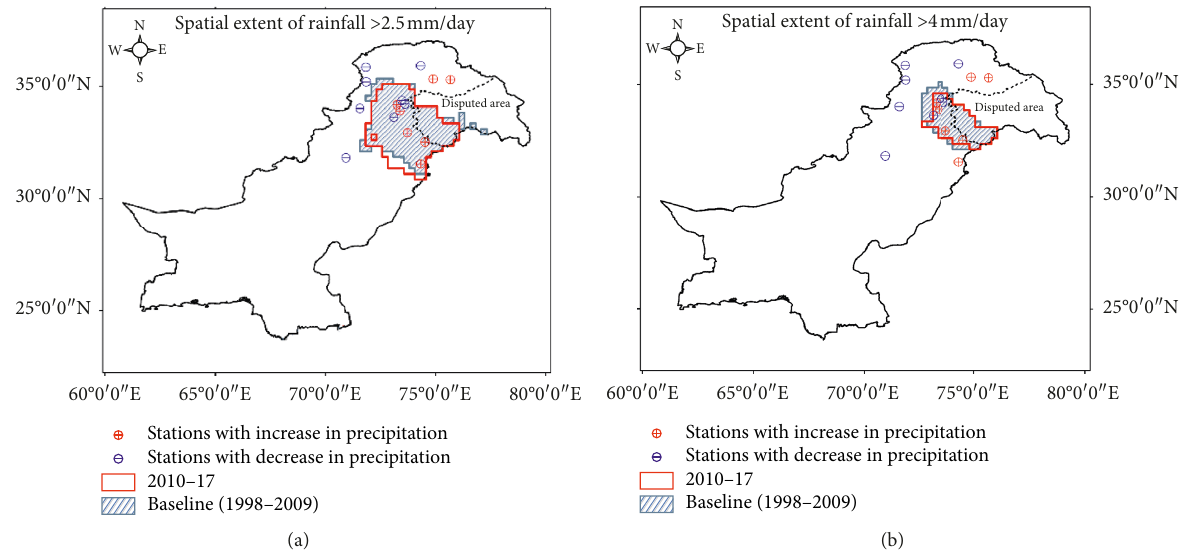
Figure 11: Spatial Shift of monsoon in northern monsoon belt of Pakistan. There is an increase in monsoon hit area with rainfall day of 56033km 2 and a decrease of 25,261 km 2 in area with rainfall respective scenarios.